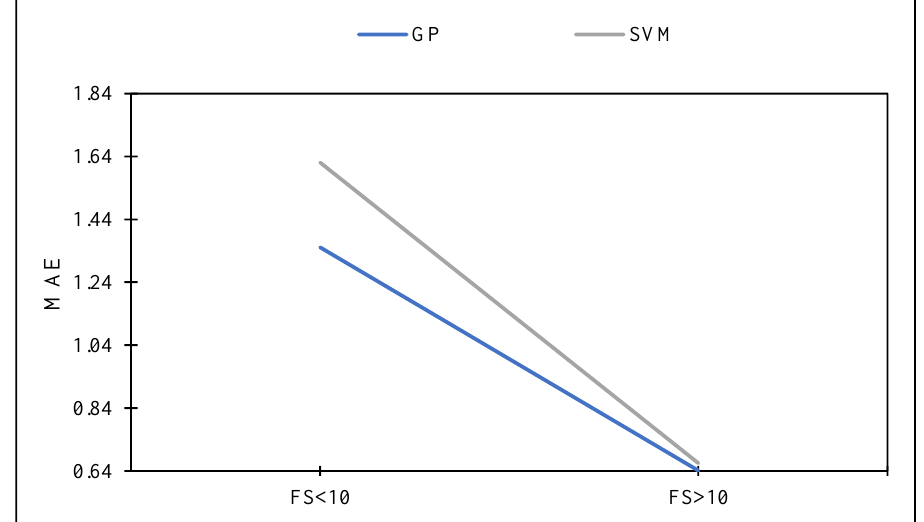
Figure 12. Relationship between Flexural Strength and MAE.